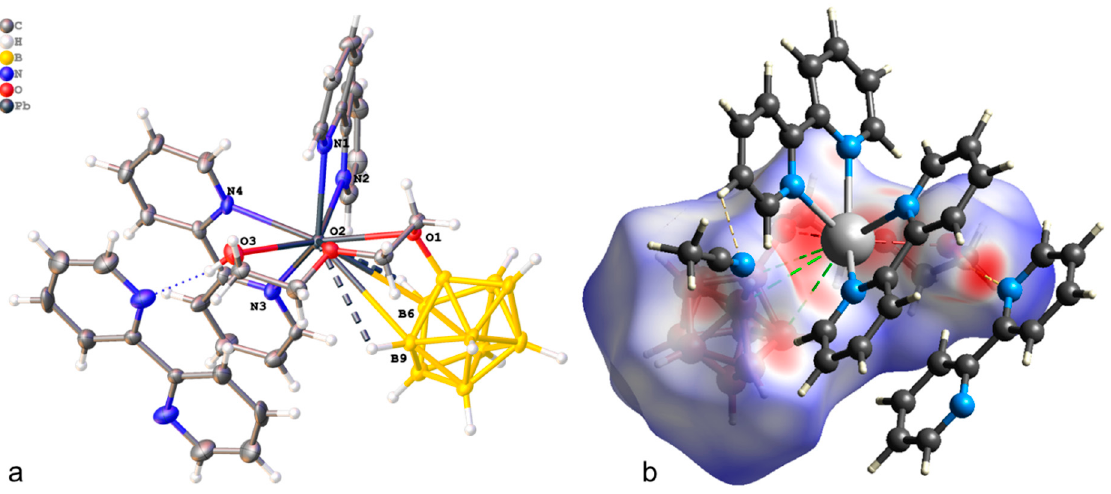
Table 2. On the Hirschfeld surface of the boron anion (Figure 3b), the Pb–B contacts are shown as dashed green lines, and the Pb–P contacts as dashed red lines.